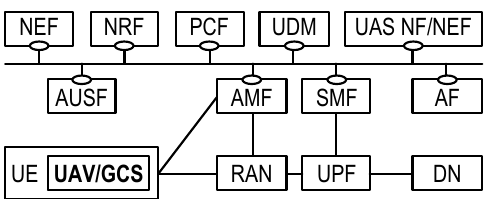
Figure 5. The 5GS non-roaming architecture for a UAV, defined by